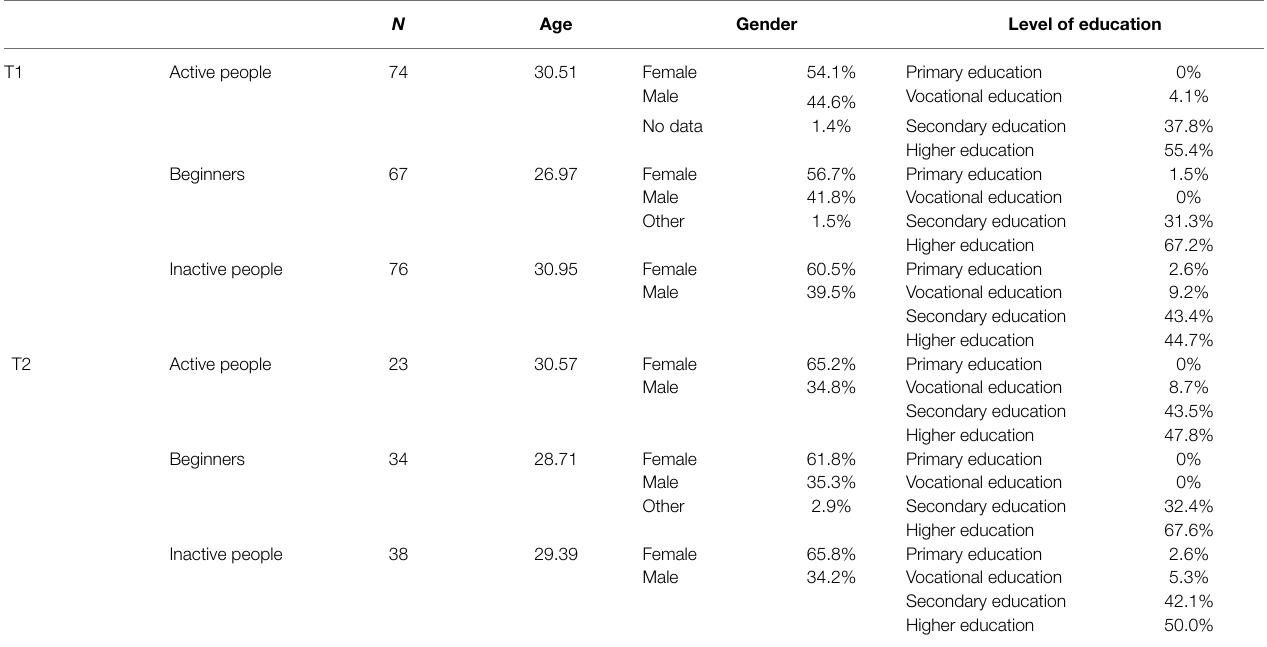
TABLE 1 | Demographic data (age, gender, and education level) data divided into groups for first (T1) and second (T2) measurement. N Age